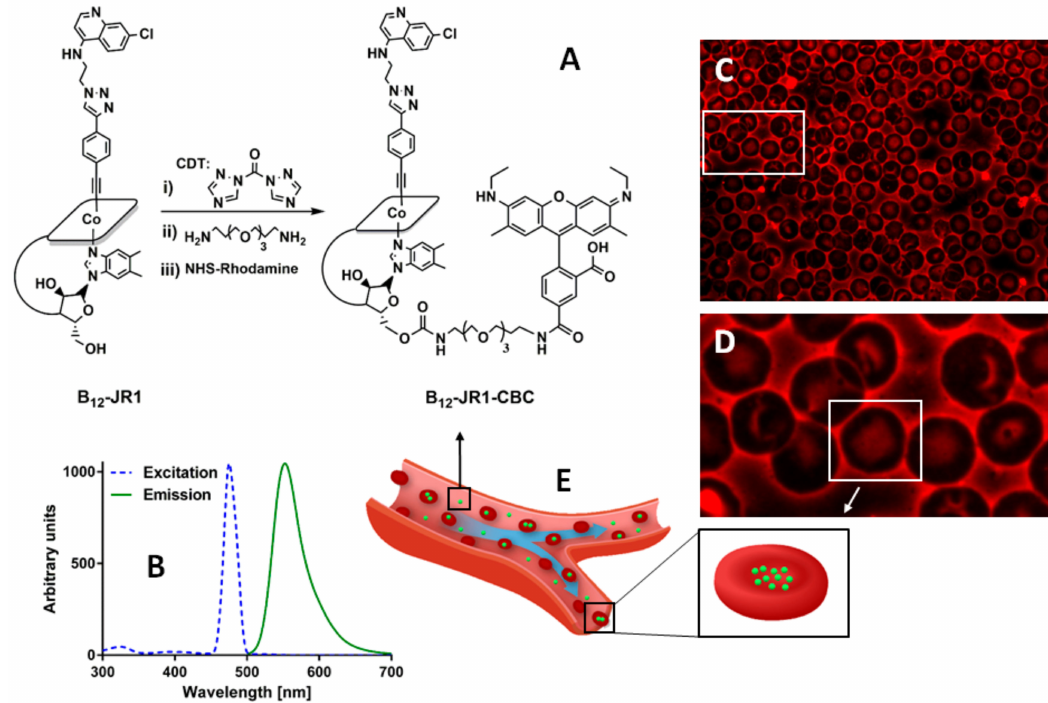
Figure 4. ( A ) Reaction steps leading to the synthesis of the green emitting B 12 - JR1 - CBC . Conditions: (i) CDT, 12 h, DMSO; (ii) PEG, 12 h, anhydrous DMF; (iii) NHS-rhodamine, 12 h, TEA, anhydrous DMF. ( B ) Normalized excitation and emission profile of B 12 - JR1 - CBC in a 1:1 H 2 O / MeOH solution. ( C , D ) Fluorescent microscope images of erythrocytes within full canine blood smear incubated with B 12 - JR1 - CBC at 37 ◦ C (GFP filter; 100 × magnification). ( E ) Conceptual drawing of B 12 - JR1 - CBC accumulation within erythrocytes. Note : as a full blood smear was made, fluorescence around red blood cells is due to serum and / or burst